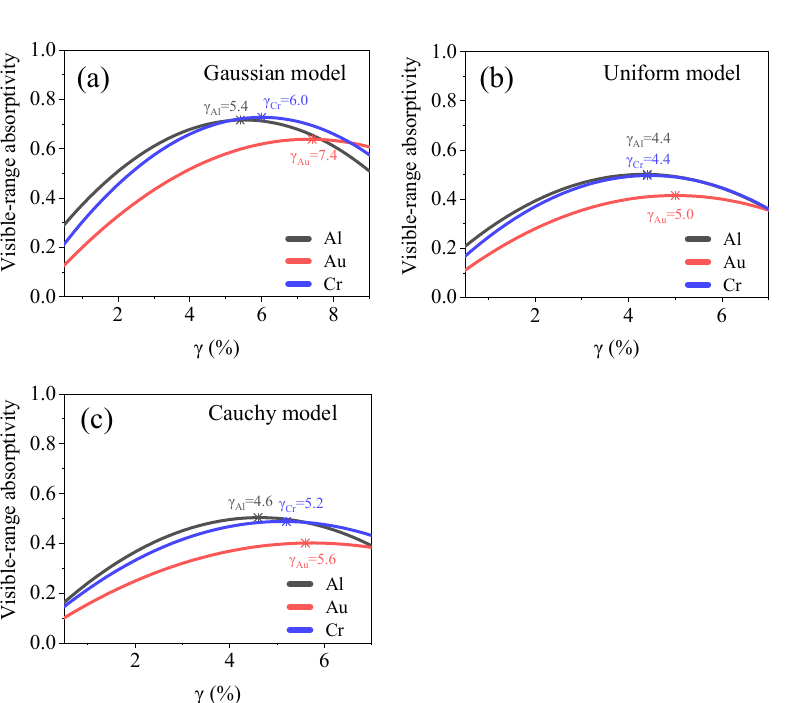
Figure 5. Relationship between optical absorption and filling factor for ( a ) Gaussian, ( b ) uniform, and ( c ) Cauchy models. Filling factor of each model and maximum absorptivity are shown in the figures. Table 1. Relationships between model parameters and visible-range absorptivity. Type of Extreme Values for Gaussian, Parameter Material of the Models Relationship Curve Uniform and Cauchy Models